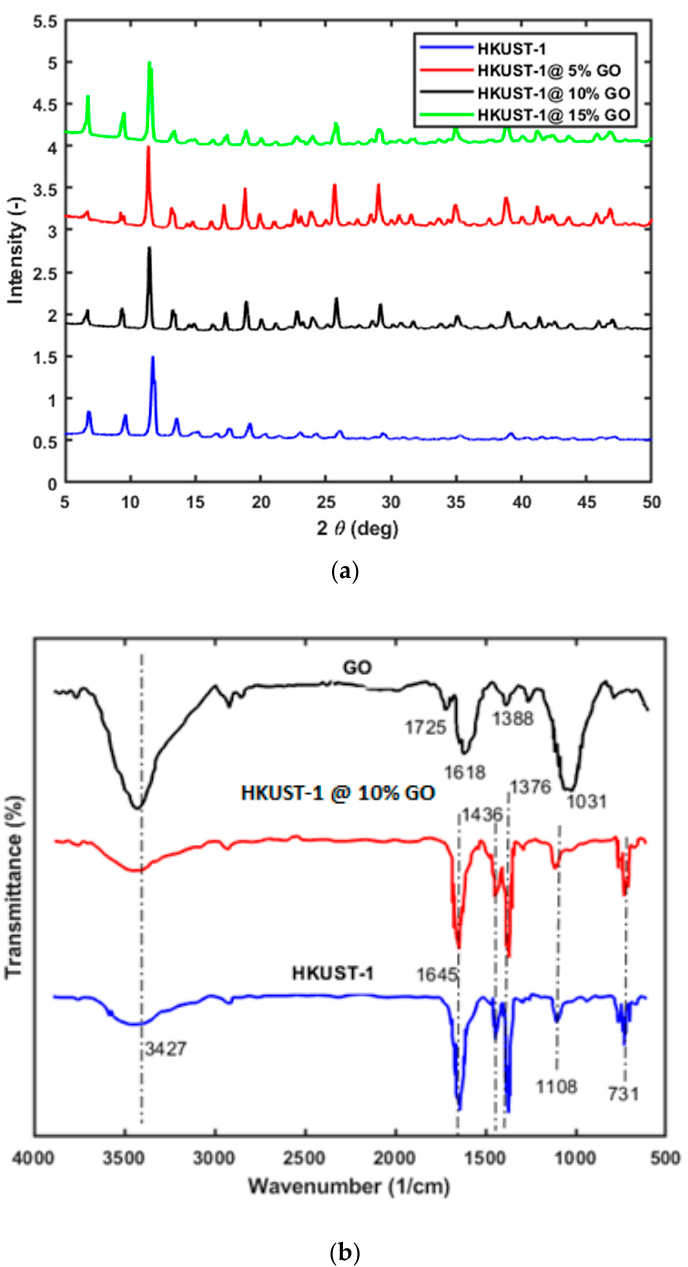
Figure 2. ( a ) Powder diffractograms of HKUST ‐ 1 and HKUST ‐ 1/GO composites. ( b ) FTIR spectra of GO, HKUST ‐ 1, and HKUST@ 10% GO samples.